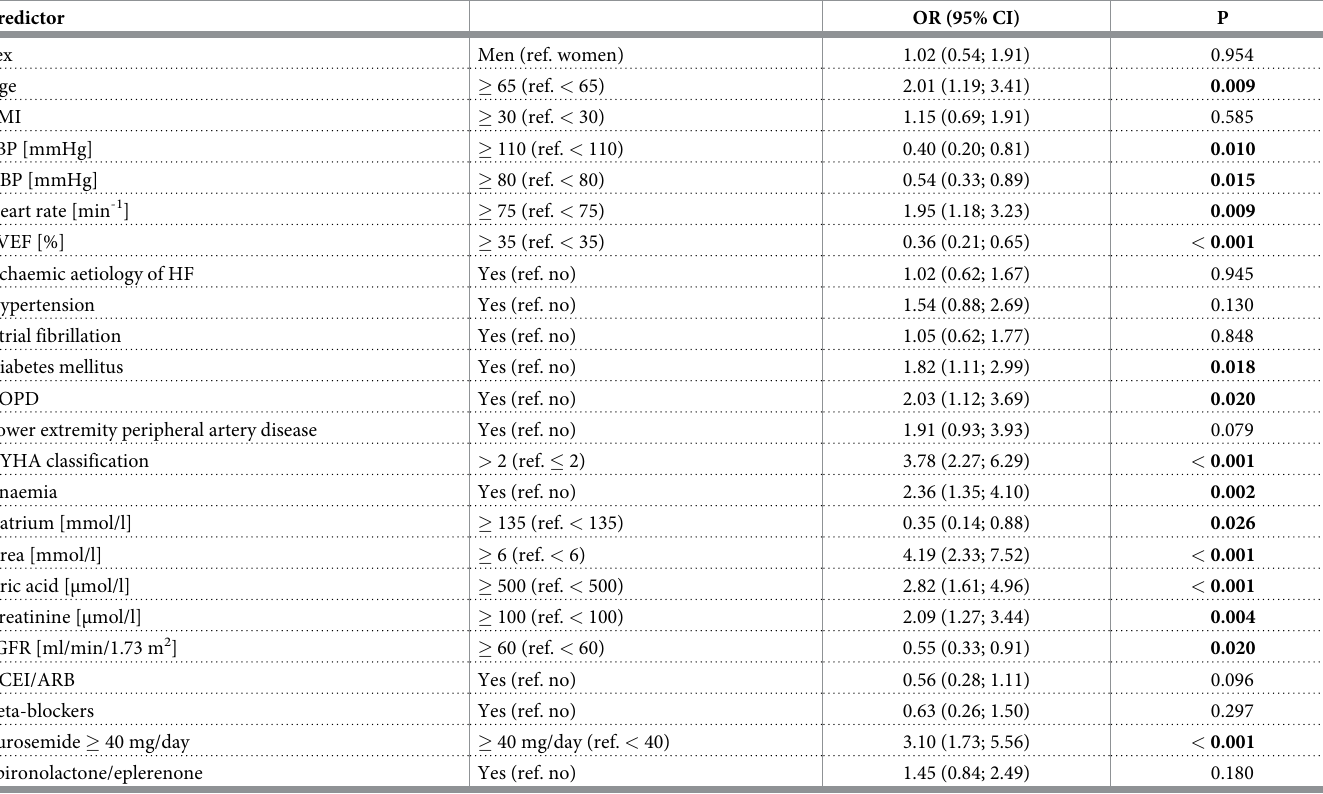
BMI, body mass index; COPD, chronic obstructive pulmonary disease; DBP, diastolic blood pressure; HF, heart failure; LVEF, left ventricular ejection fraction; SBP, systolic blood pressure; eGFR, estimated glomerular filtration rate (using the CKD-EPI